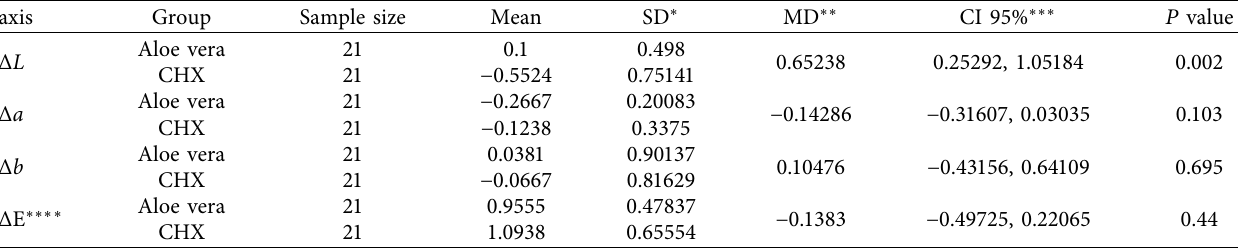
Table 2: The comparison of mean Δ E color difference between the groups (independent sample test).